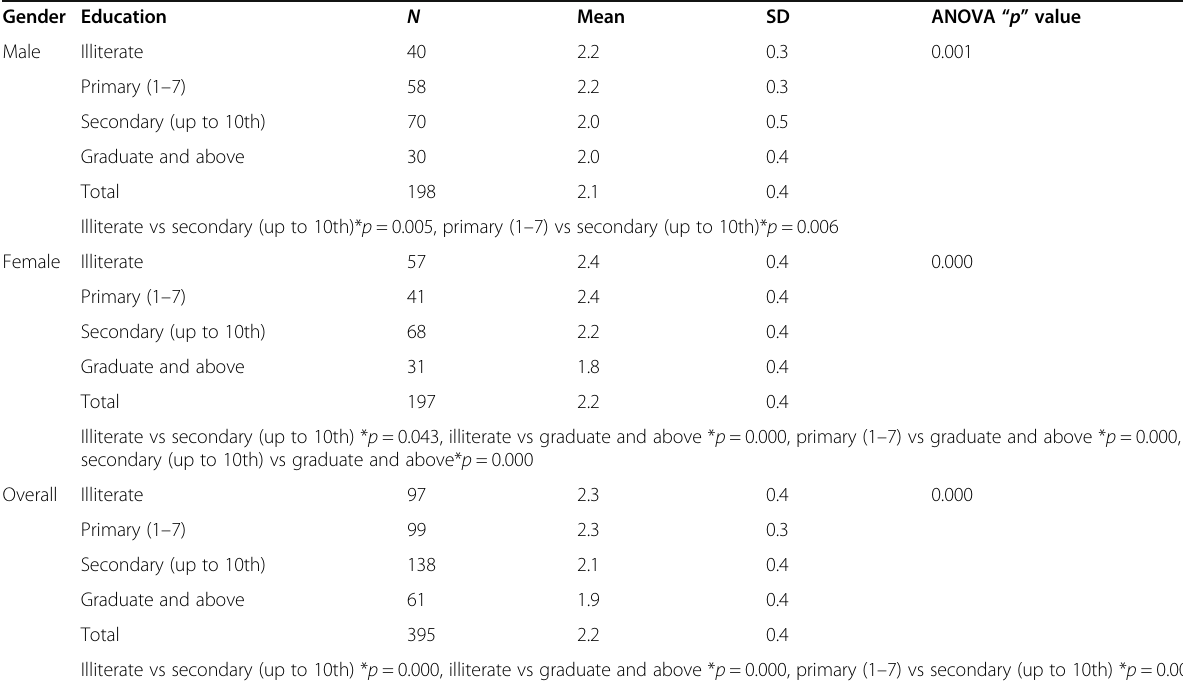
Table 3 Comparison of public attitude score towards mental healthcare facilities by education level within gender Gender